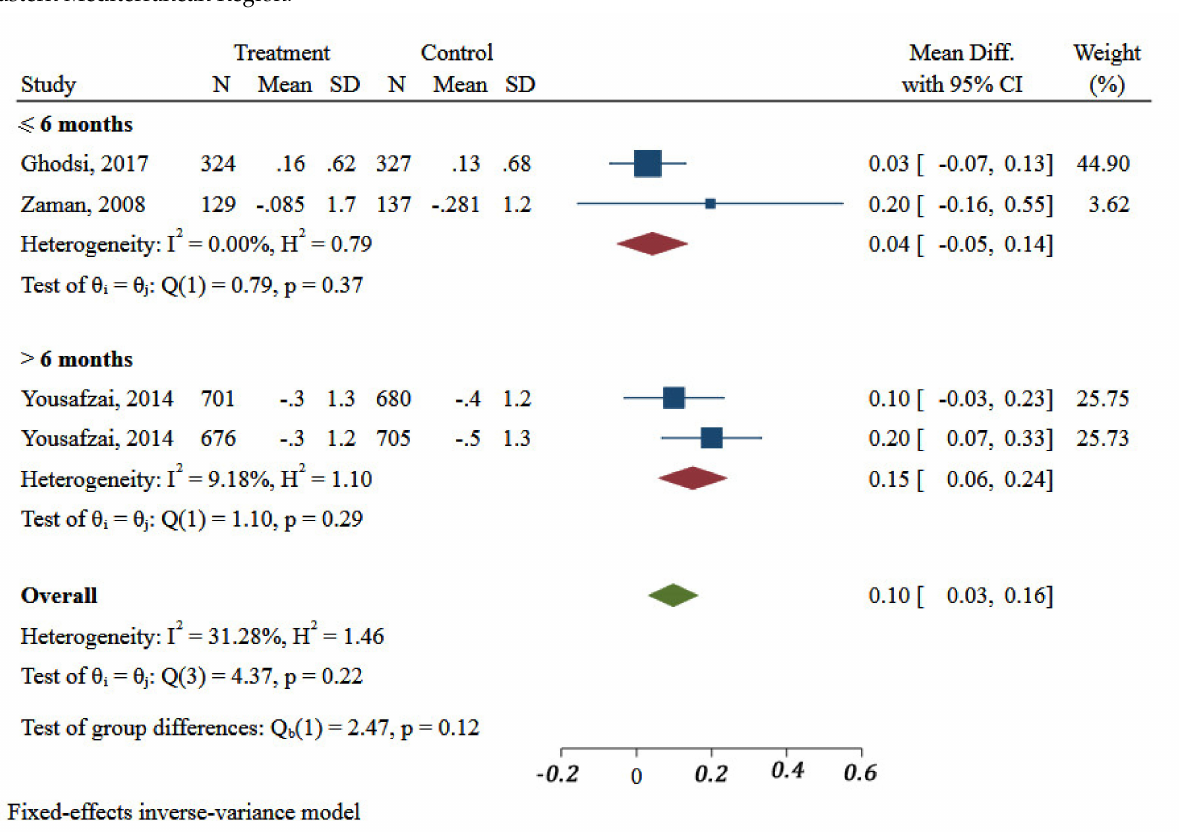
Figure 4. Impact of different community-based nutrition interventions on Weight-for-Age Z-score of children under 5 in Eastern Mediterranean Region.